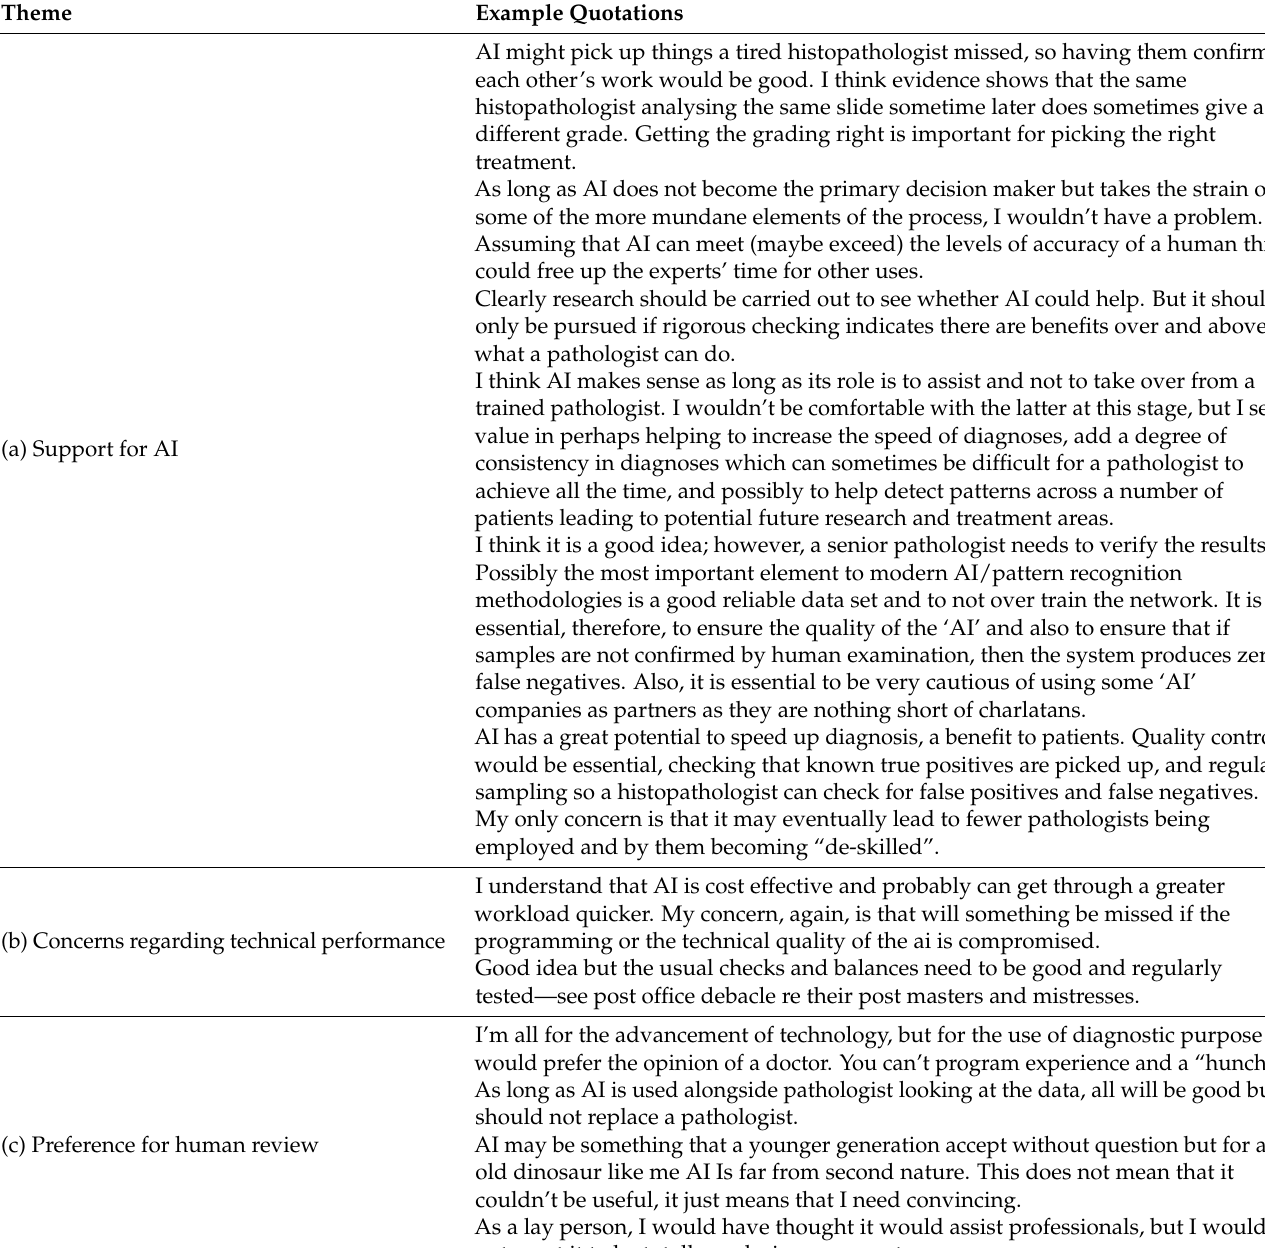
Table 2. Example free text quotations from respondents on their views regarding the introduction of AI into routine histopathology